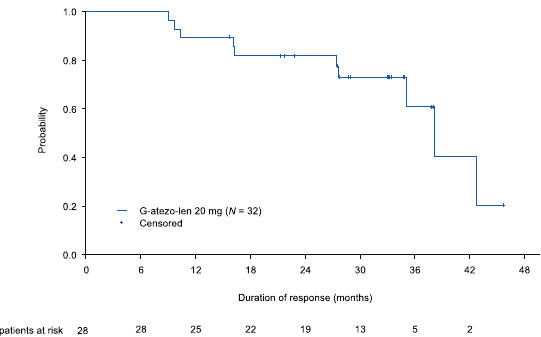
Fig. 3 Duration of response* in 32 patients receiving G-atezo-len (INV-assessed, ef fi cacy-evaluable population; 36-month cutoff: 7 October 2020). *Duration of response was de fi ned as time from the fi rst occurrence of a documented objective response to the time of disease progression or relapse, as determined by the investigator on the basis of CT scans alone or death from any cause, whichever occurred fi